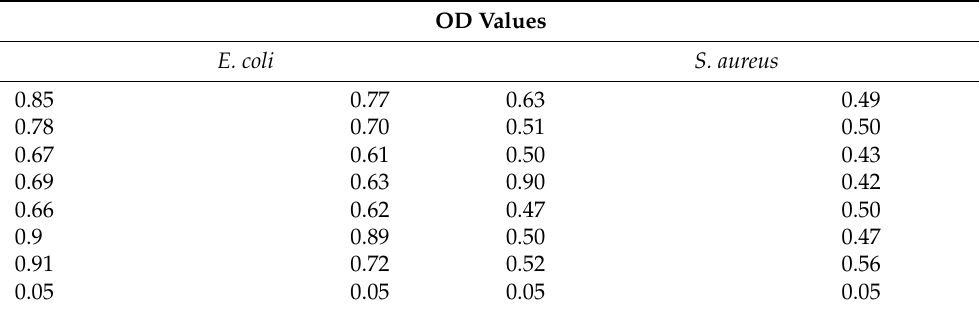
Table 5. OD values for bacterial strains E. coli ATCC 35218 and S. aureus ATCC 29213 treated with GQD-EDA/1